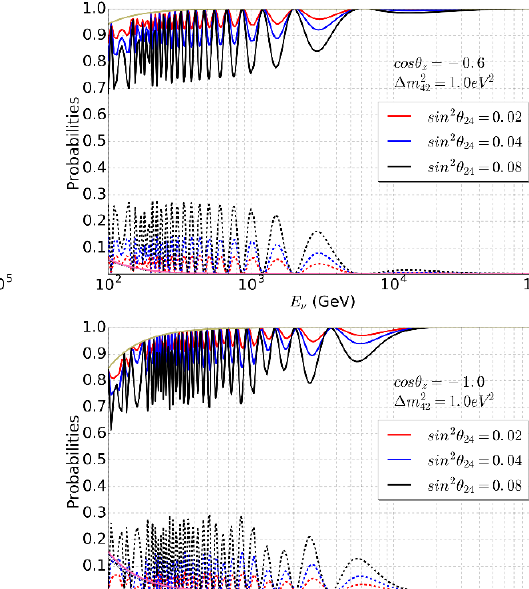
JHEP03(2019)203